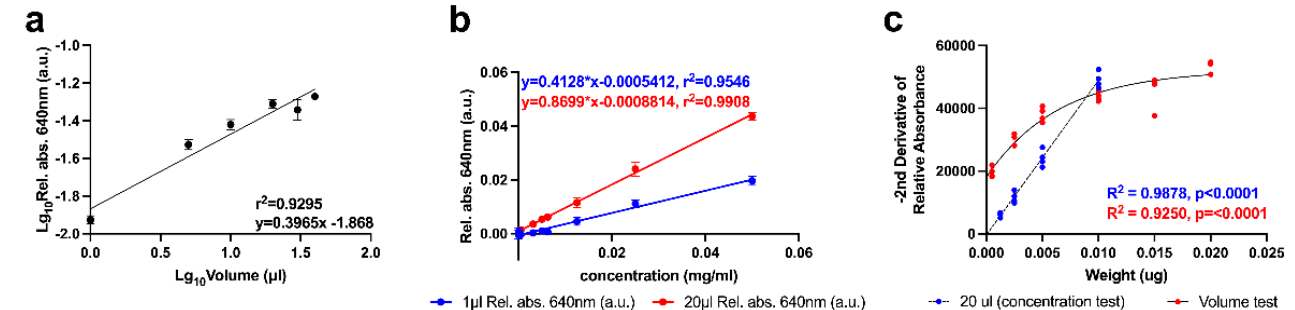
Figure 4. Correlation analysis was performed for ( a ) volume/relative absorbance at 640 nm (N = 6); ( b ) Concentration/relative absorbance at 1 mL (blue) and 20 mL (red). Pearson’s correlation test was performed; data are presented as mean +/− s.d. (N = 9 with 4 replicas for each measurement). ( c ) Correlation analysis for weight/second derivative of relative absorbance by varying concentration at 20 mL (in blue performed with Pearson’s correlation showing r = 0.9939) and volume (in red performed with Spearman showing r = 0.9587).